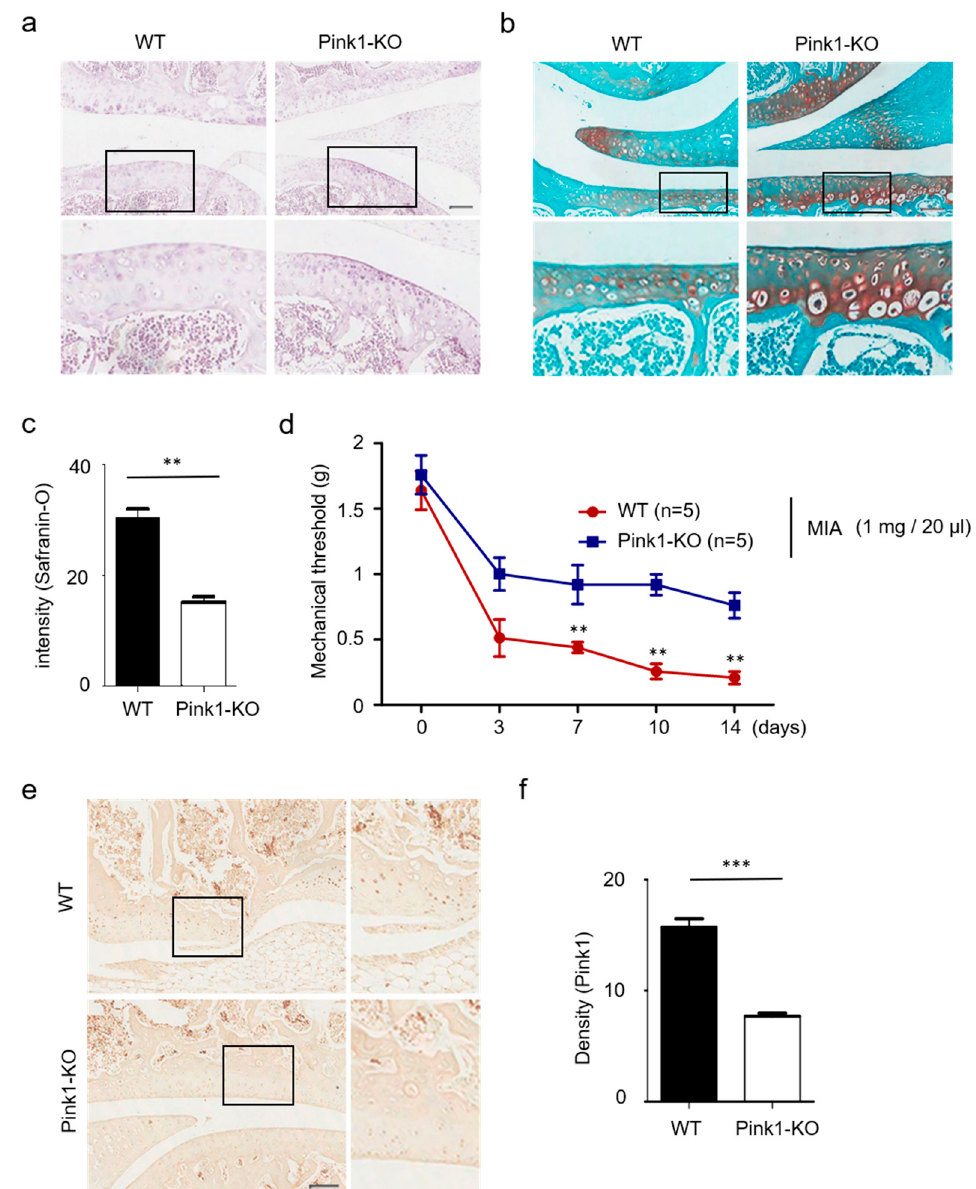
Figure 4. Reduced cartilage damage in Pink1-deficient mice. ( a , b ) Hematoxylin and safranin-O staining of knee cartilage treated with 1 mg/20 µL MIA for 3 days. Pink1 knockout decreased knee cartilage destruction in MIA-treated mice. ( c ) Quantification of cartilage destruction and mitophagy-associated autophagic chondrocyte death in safranin-O staining. ( d ) The mechanical threshold was measured on days 0, 3, 7, 10, and 14 after MIA injection by von Frey test. ( e ) Increased Pink1 immuno-reactivity was observed in knee joints of Pink1 knockout mice relative to littermate controls. ( f ) Quantitative analysis of Pink1 expression in mouse Pink1 knockout chondrocytes by Image J. Scale bars = 50 µM. 3.4. Autophagy and Mitophagy-Related Genes are Highly Expressed in Human Osteoarthritic Cartilage Strong induction of LC3B and p62 protein expression was observed in the superficial zone of degenerating human articular cartilage in OA patients (Figure 5a,b). Immunohistochemistry analyses further revealed increases in Pink1-positive chondrocyte numbers in osteoarthritic joint cartilage, with Pink1 expression levels consistently higher in injured sites relative to less involved areas (Figure